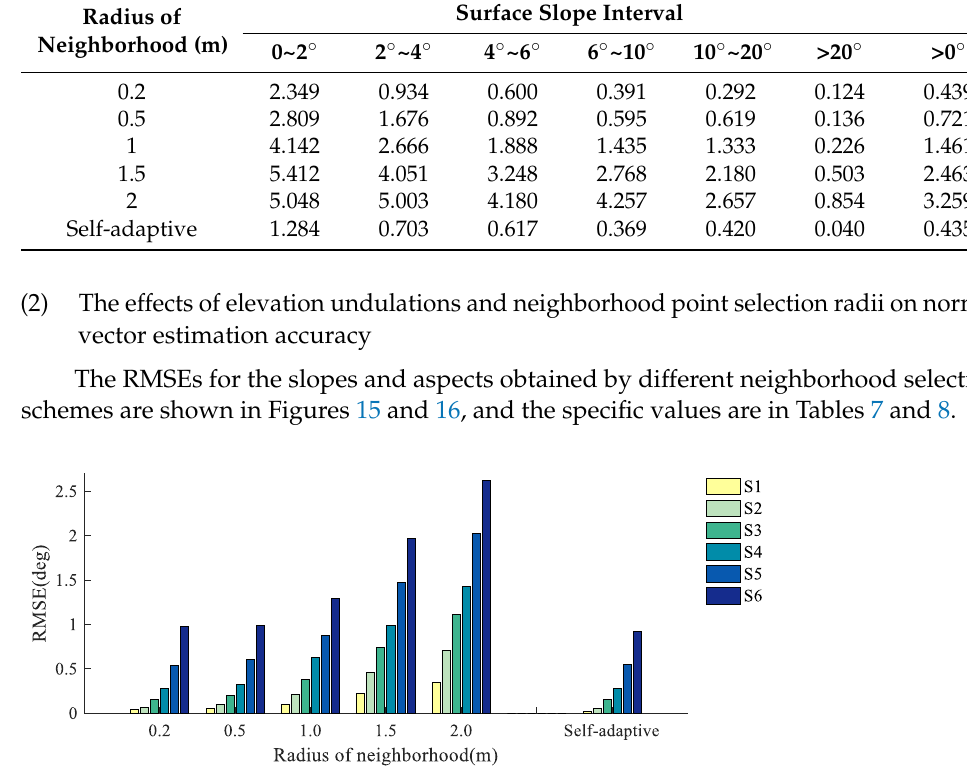
Figure 16. Accuracy of surface slope estimation with different surface complexities and selection ranges of neighborhood points. Table 7. Root mean square error of wave surface slope estimation.